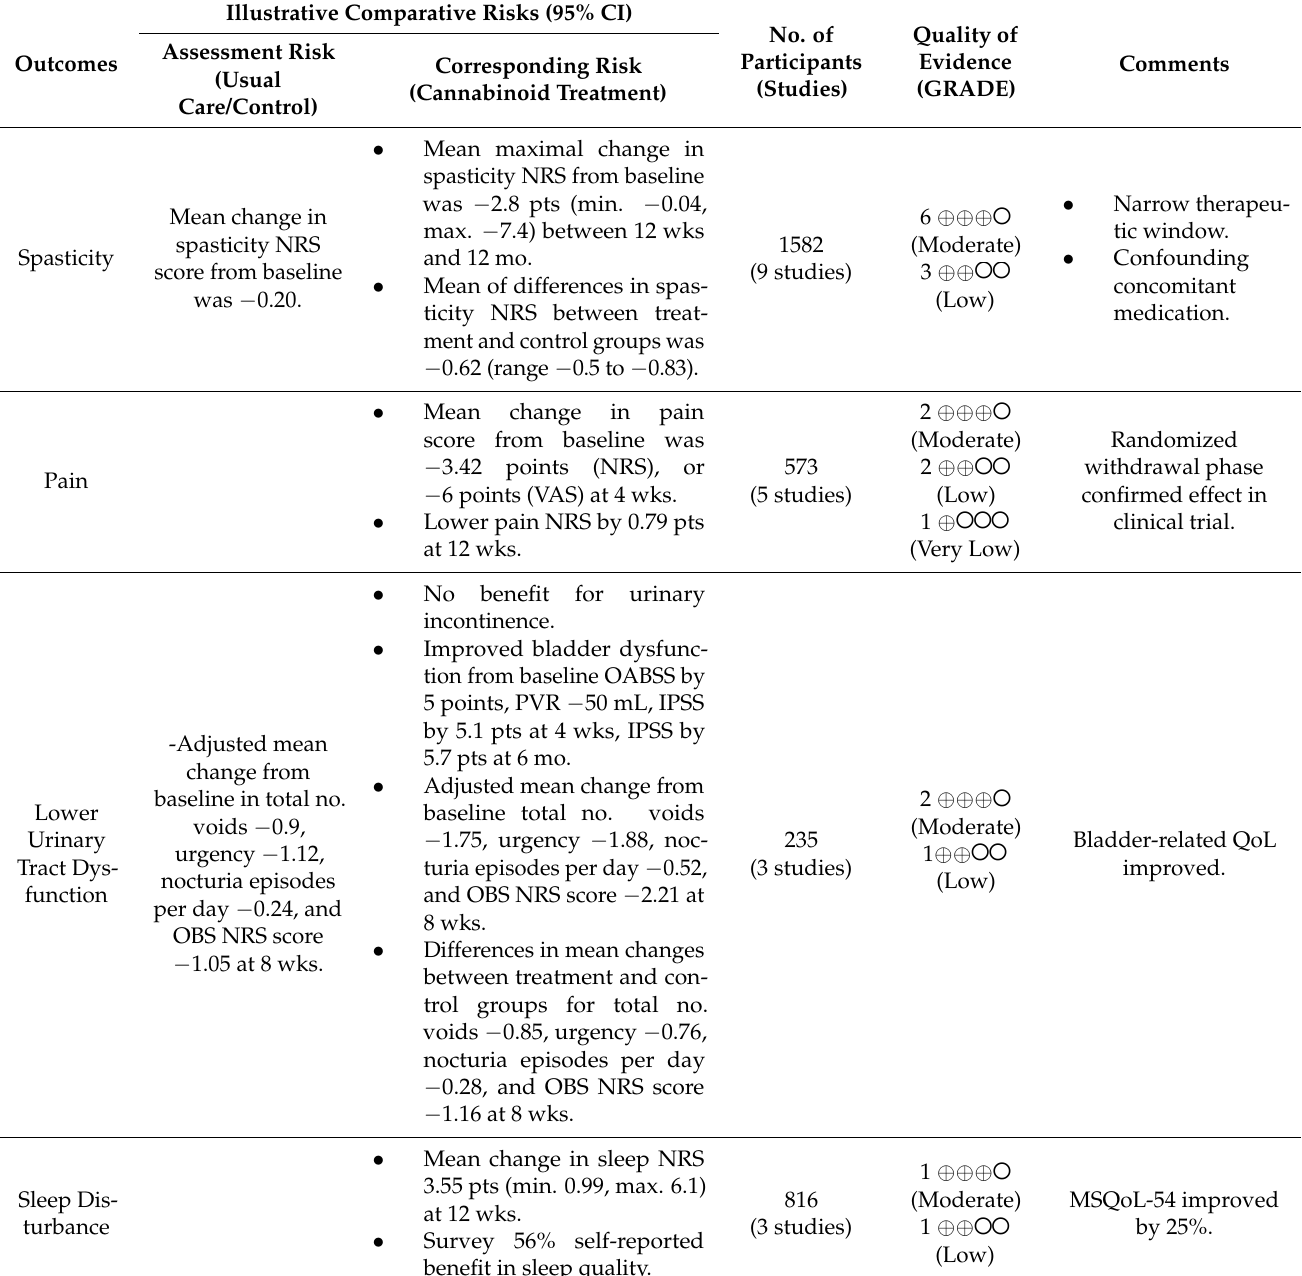
Table 8. Summary of findings.